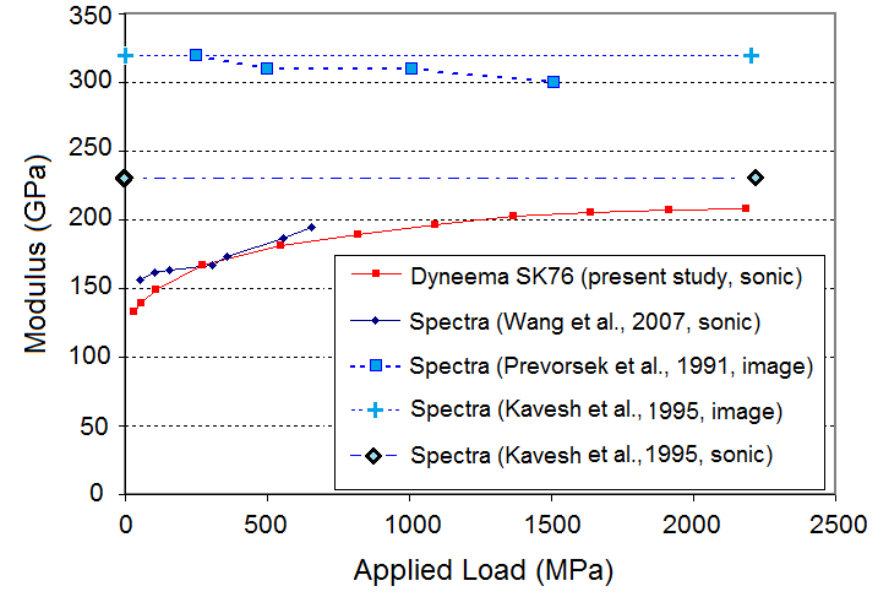
Figure 10. Comparison of various Young’s results reported in the literature for UHMWPE fiber in connection to yarn shooting experiments.